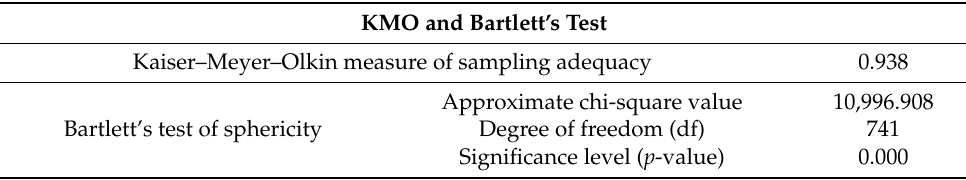
Table 10. Results of the Kaiser-Meyer–Olkin and Bartlett’s Test.